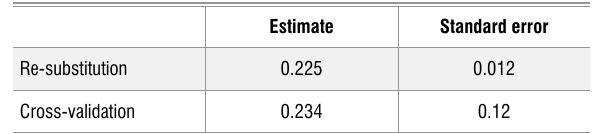
Risk estimate of the classifier